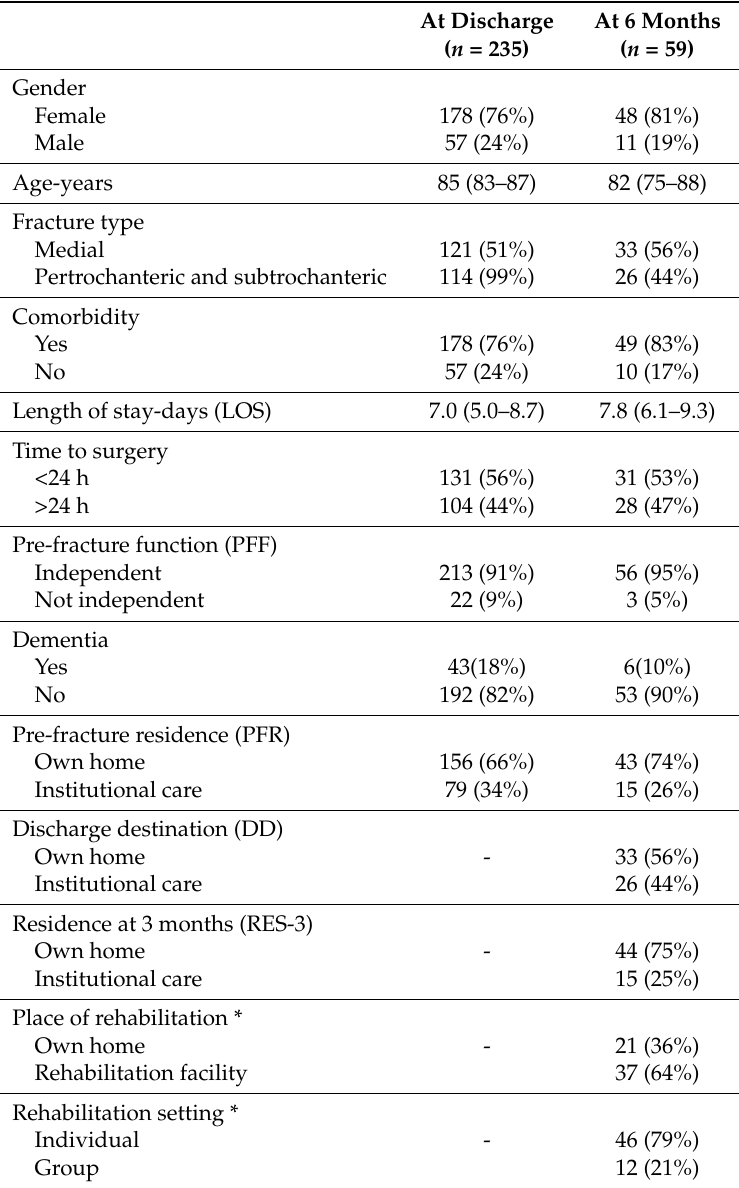
Table 1. Baseline demographics and clinical